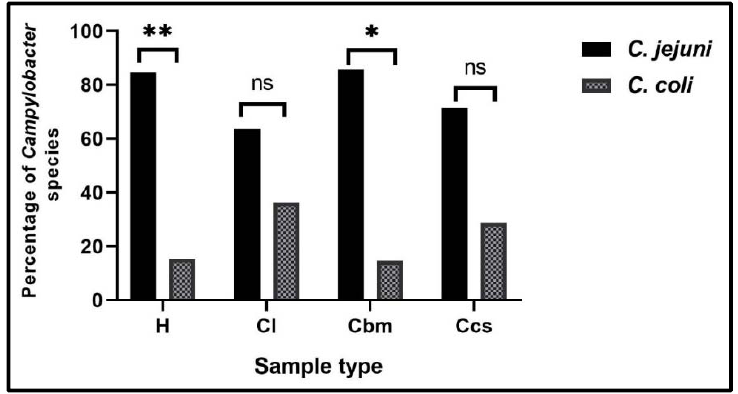
Figure 6. Prevalence of molecularly identified Campylobacter species in different samples. H: human stool swabs, Cl: chicken liver, Cbm: chicken breast meat, Ccs: chicken cloacal swabs, ns: